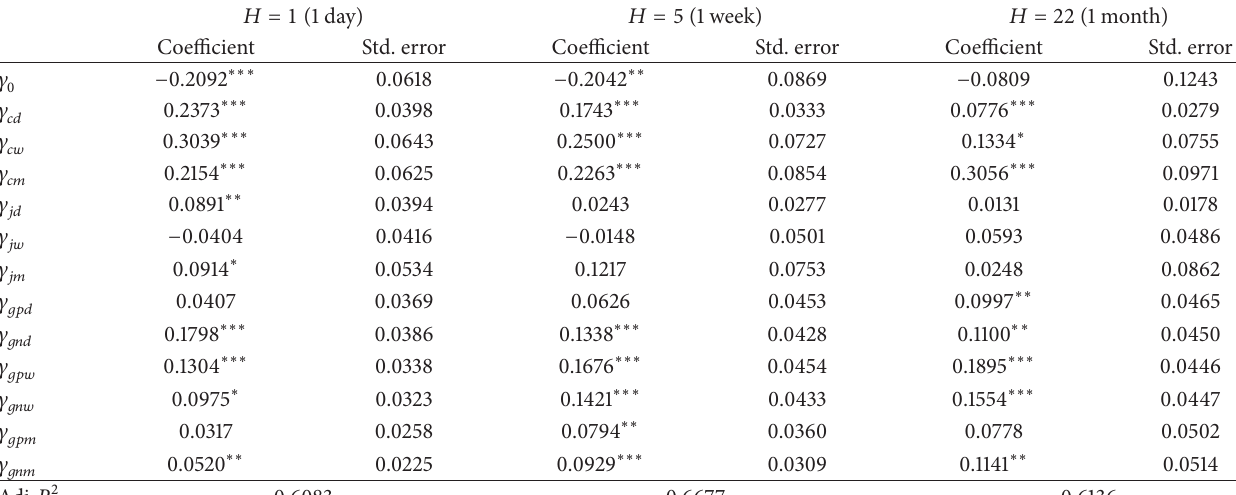
Table 5: Estimation results of the HAR-CJ-M model.